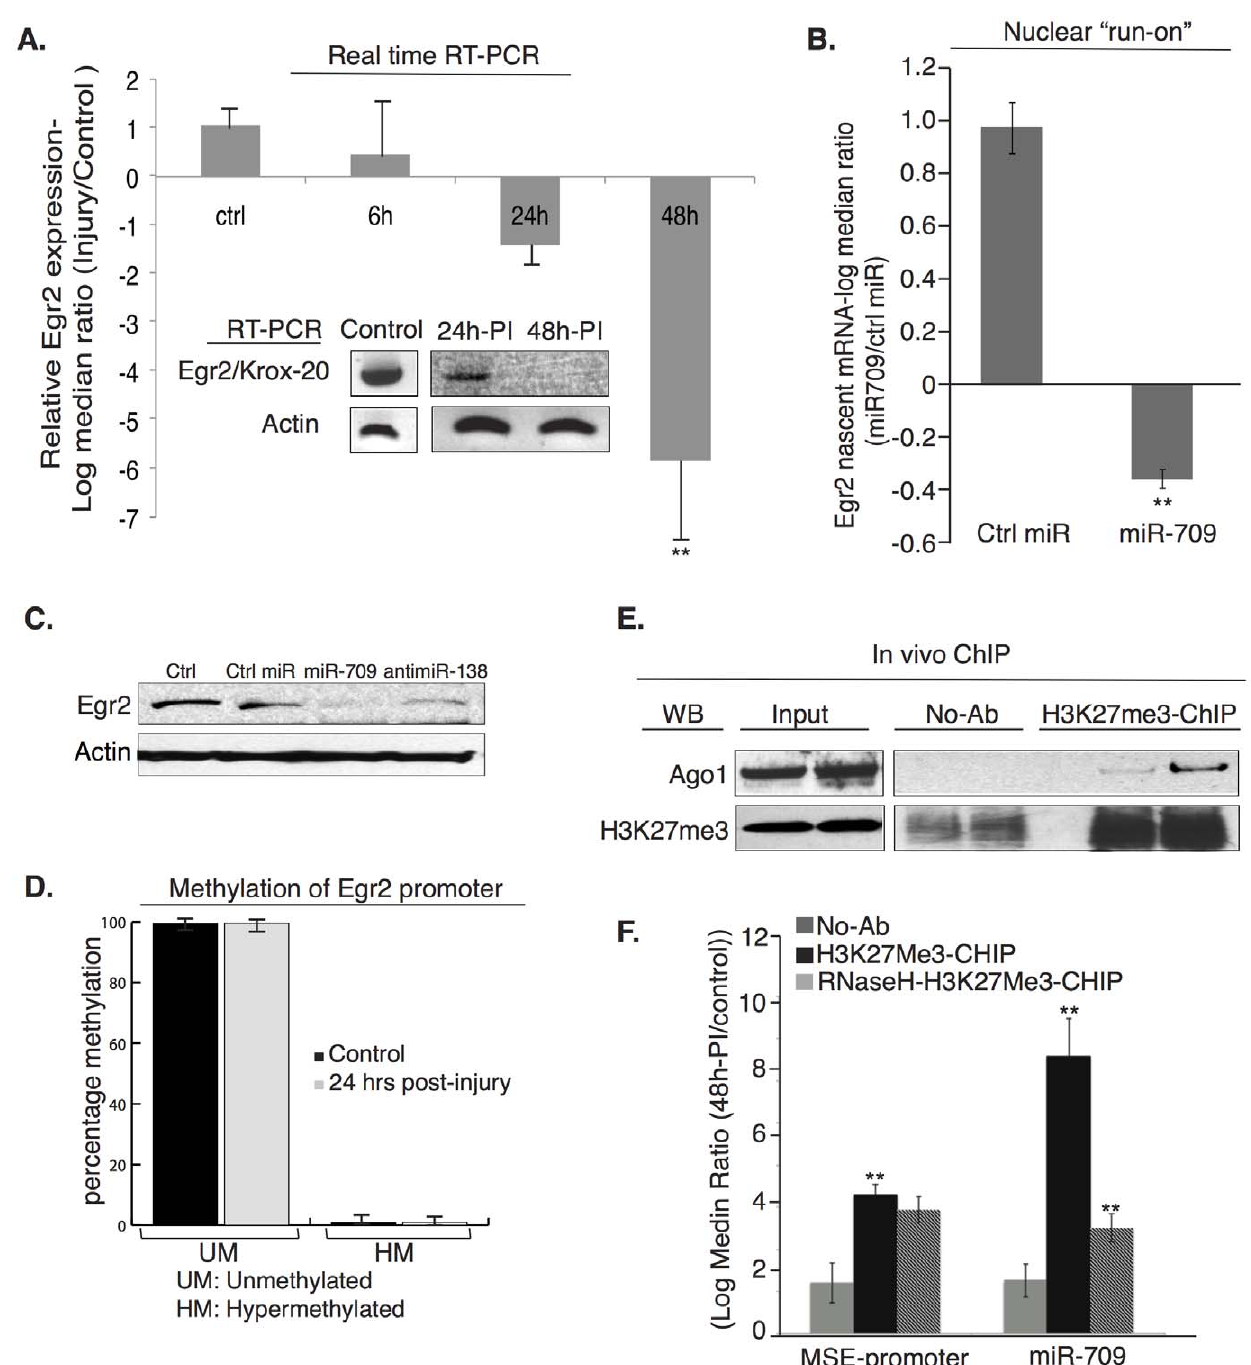
Figure 5. miRNAs mediate transcriptional gene silencing of Egr2. (A). Real-time qRT-PCR of Egr2 transcripts normalized to GAPDH control 6, 24 and 48 hours post-injury as compared to control uninjured nerves. Fold difference (2 - DD CT ) between injured and control nerves is plotted and error is expressed as standard deviation. Inset: Egr2 mRNA expression at 24 hours and 48 hours after injury as compared to Egr2 mRNA expression in uninjured nerves. Egr2 mRNA expression is completely inhibited 48 hours post-injury. Beta-actin was used to show equal loading and amplification. (B). Nuclear ‘‘run-on’’ experiment for nascent Egr2 mRNA transcription in rat Schwann cells transfected with control or miR-709 duplexes as measured by quantitative RT-PCR and normalized to GAPDH mRNA transcription levels. The experiment was repeated three times, the data were normalized to GAPDH and fold difference (2 - DD CT ), between injured and control nerves was plotted as a log-2 median ratio. Error is expressed as standard deviation, (**: p , 0.005). (C). Egr2 protein expression in Schwann cells transfected with miR-709, antimiR-138 or non-targeting control miRNA and compared with non-transfected Schwann cells. (D). Methylation PCR analysis (SA Biosciences) of the CpG islands of the proximal Egr-2 promoter from control and injured sciatic nerves (24h-post injury). The relative percentages of hypermethylated (HM) and unmethylated (UM) fractions were calculated by comparing the amount in each digest with that of a mock (no enzyme added) digestion. (E). ChIP assays, using antibody to H3K27Me3 or no antibody (No Ab) controls were performed in sciatic nerves isolated from control and axotomized mice 48 hours post-injury. Western blot of input, no antibody control (No Ab) and H3K27Me3-ChIP was performed with antibodies against Ago-1 and H3K27Me3. This showed that Ago-1 is enriched in H3K27me3